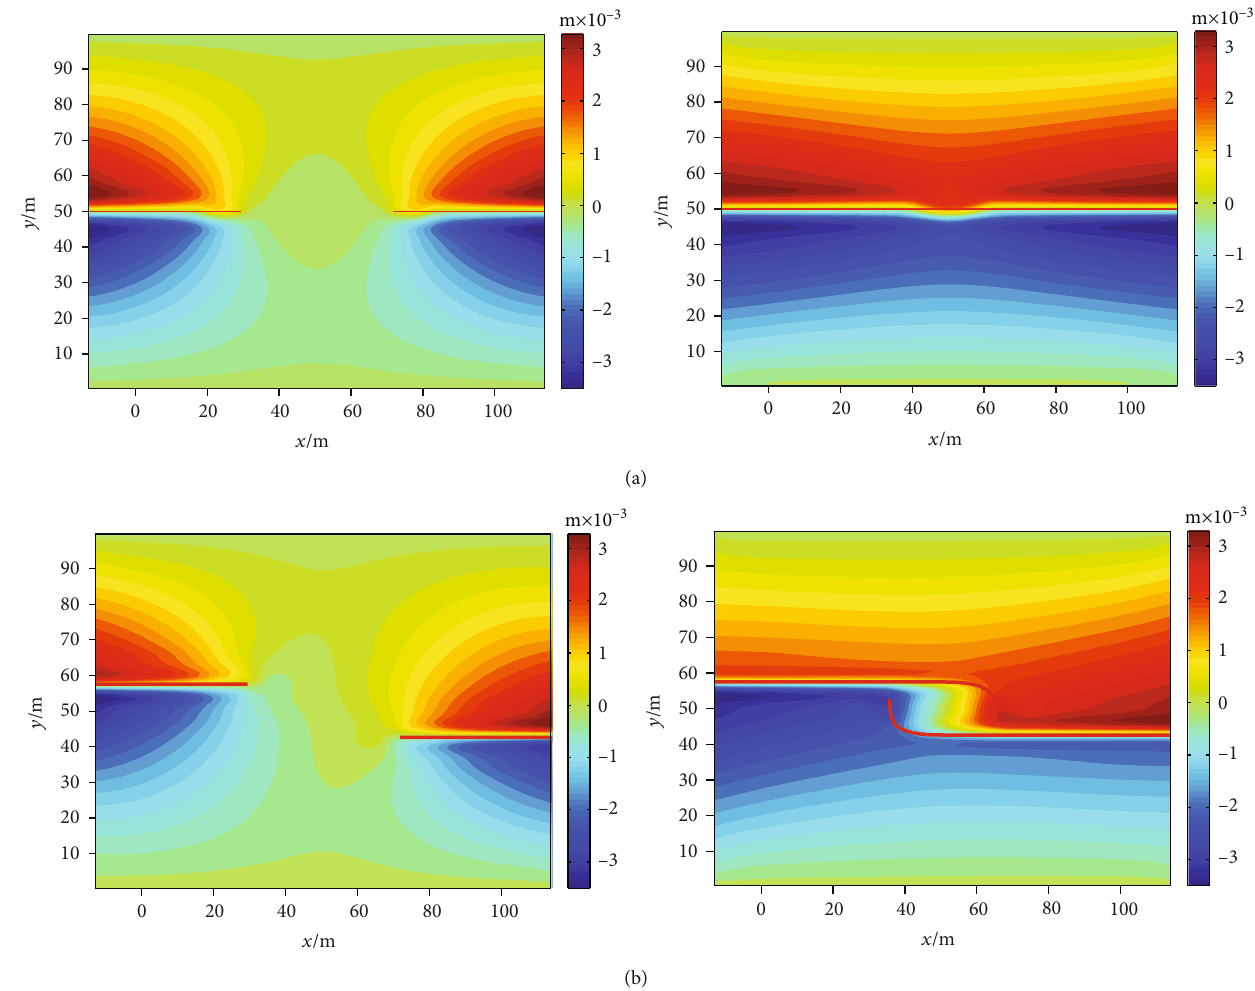
Figure 16: Fracture propagation paths: (a) lateral spacing 0m; (b) lateral spacing 15